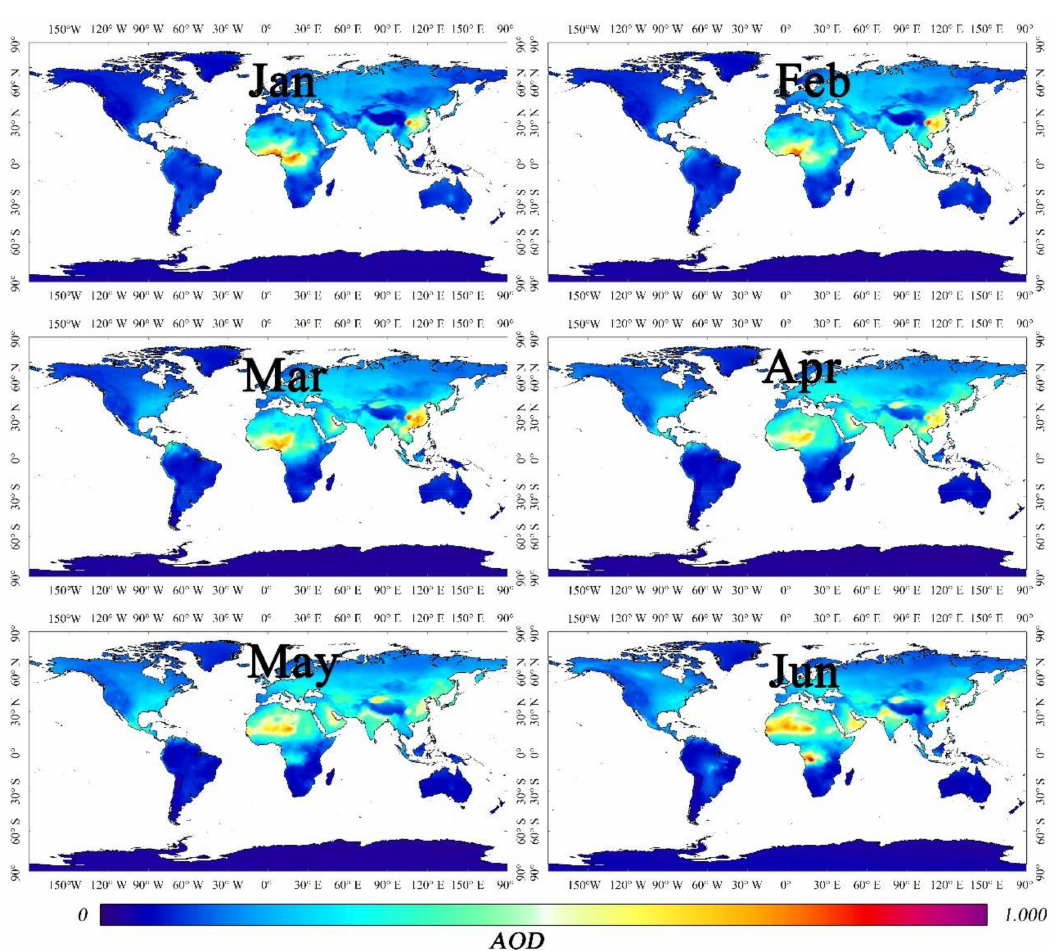
Figure 3. The global spatial and monthly variations of AOD values from January to